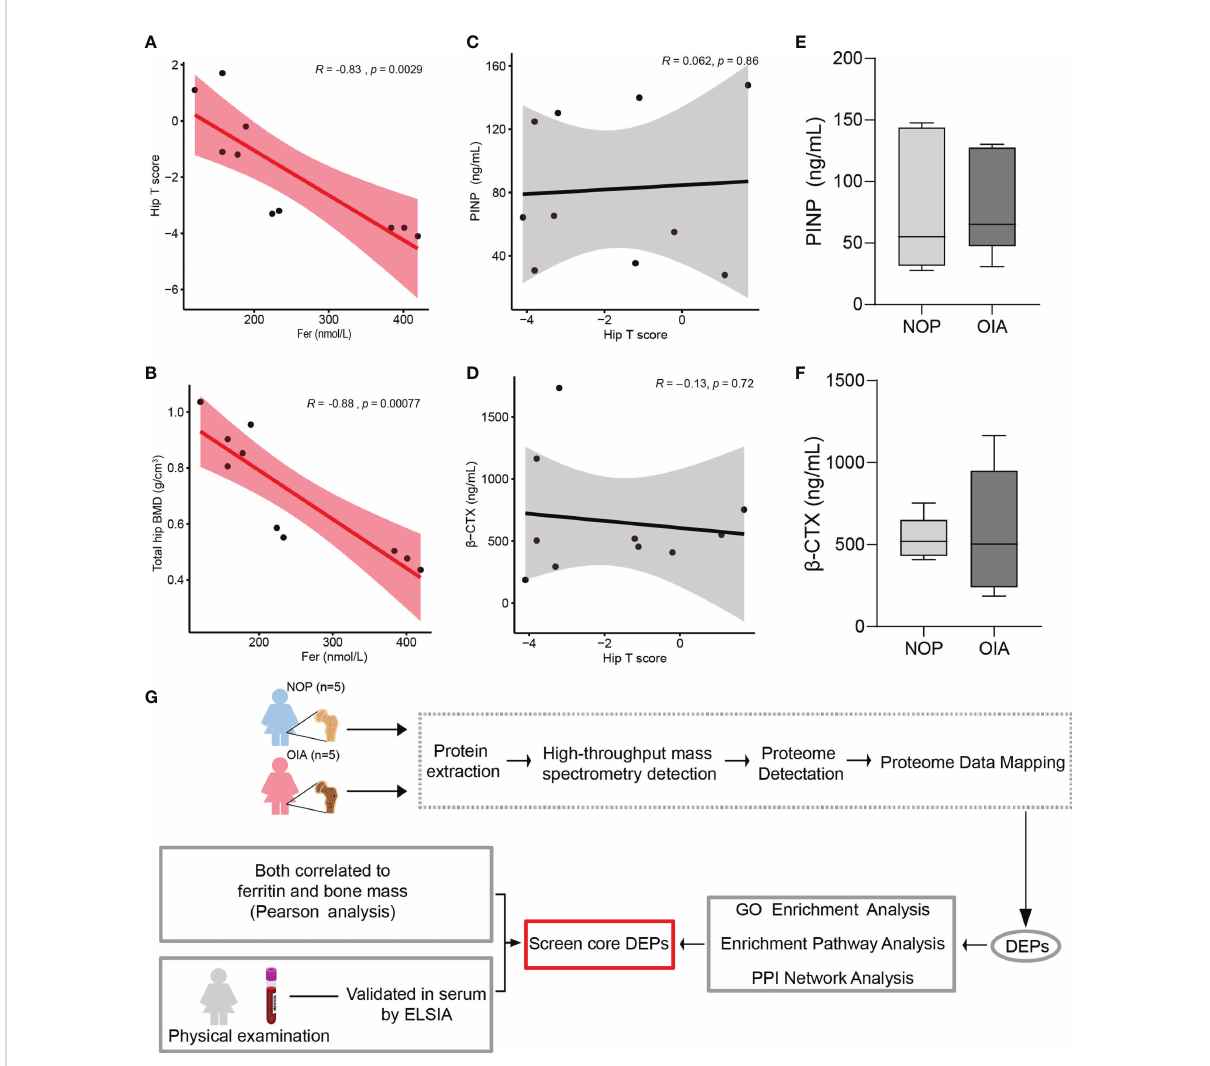
FIGURE 1 Correlation analysis of clinical index, proteomic analysis work fl ow. (A) Pearson correlation analysis of hip T score and serum ferritin. (B) Pearson correlation analysis of total hip bone mineral density and serum ferritin. (C) Pearson correlation analysis of serum PINP and hip T score. (D) Pearson correlation analysis of serum b -CTX and hip T score. (E) Serum PINP level of patients from Group NOP and OIA. (F) Serum b -CTX level of patients from Group NOP and OIA. (G) Work fl ow for quantitative mass spectrometry pro fi